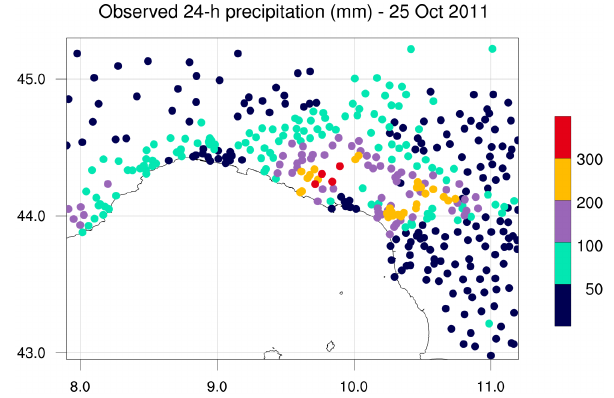
Figure 3. Observed precipitation accumulated in the 24h period starting at 00:00UTC of 4 November 2011. Parallels and meridians are drawn every 1 ◦